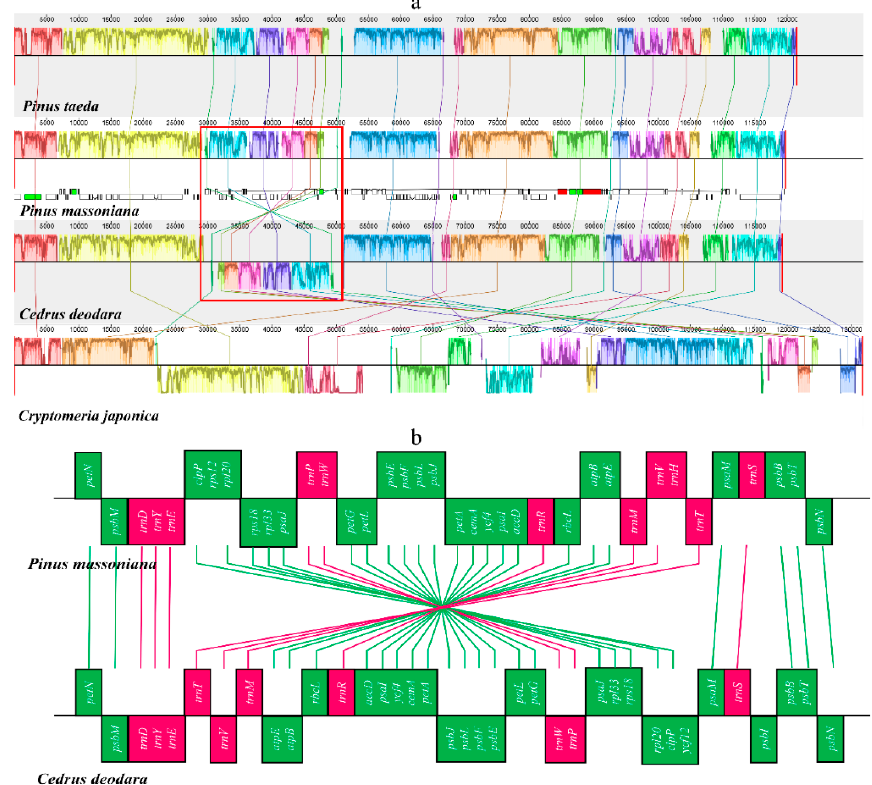
Figure 2. Synteny and rearrangements detected in chloroplast genome sequences of four Coniferous species using the Mauve multiple-genome alignment. ( b ) is a schematic illustration of the red frame part of the ( a ). ( a ) Color bars indicate syntenic blocks, and connecting lines indicate correspondence blocks; ( b ) Green boxes means protein-coding genes; red boxes means tRNAs. Boxes above and below the main line indicate the forward and reverse direction, respectively.